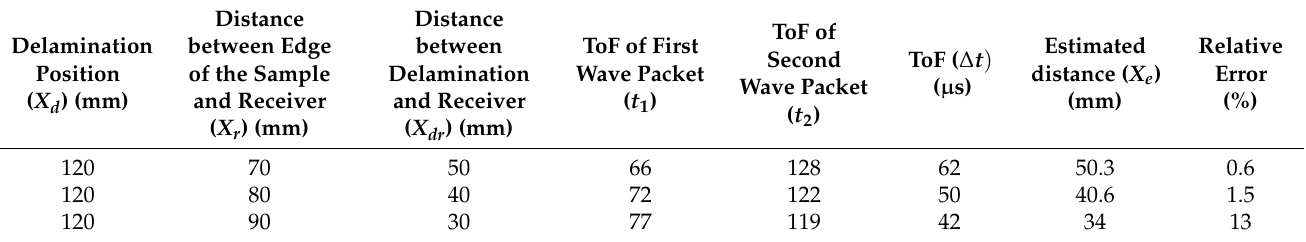
Table 5. The localization of delamination at 120 mm using different receivers.